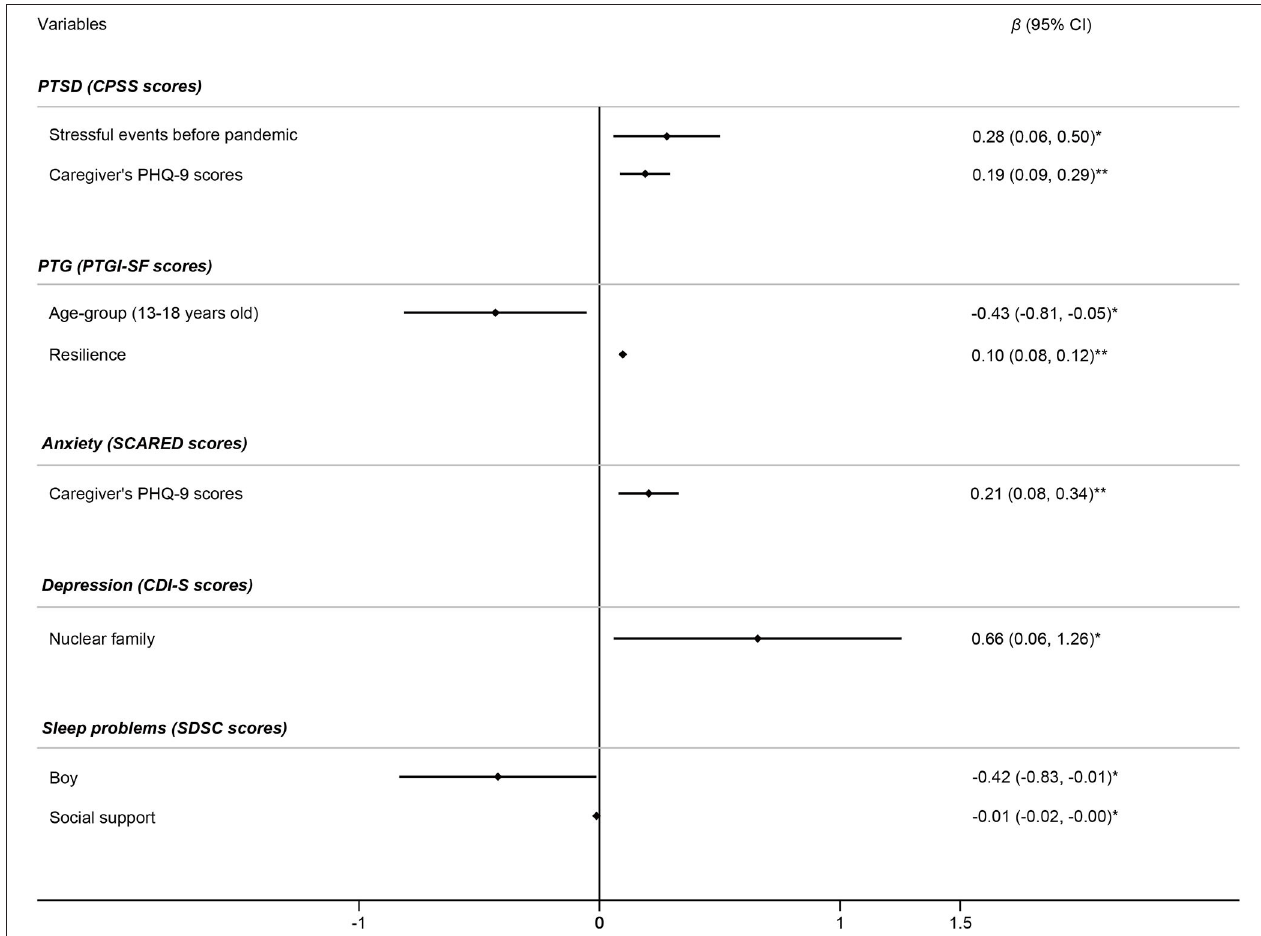
FIGURE 2 | Factors associated with mental health symptoms in discharged children ( n = 61). Initial variables in the multivariate linear regression model for PTSD included gender, age group, stressful events before the pandemic, and caregivers’ GAD-7 and PHQ-9 scores. Initial variables in the multivariate linear regression model for PTG included gender, age group, resilience, social support, and caregivers’ PHQ-9 and PSQI scores. Initial variables in the multivariate linear regression model for anxiety included gender, age group, and caregivers’ PHQ-9 scores. Initial variables in the multivariate linear regression model for depression included gender, age group, being an only child, nuclear family, length of hospitalization, and social support. Initial variables in the multivariate linear regression model for sleep problems included gender, age group, being an only child, resilience, and social support. Independent variables in the final model were determined using forward selection. * p < 0.05, ** p < 0.01.